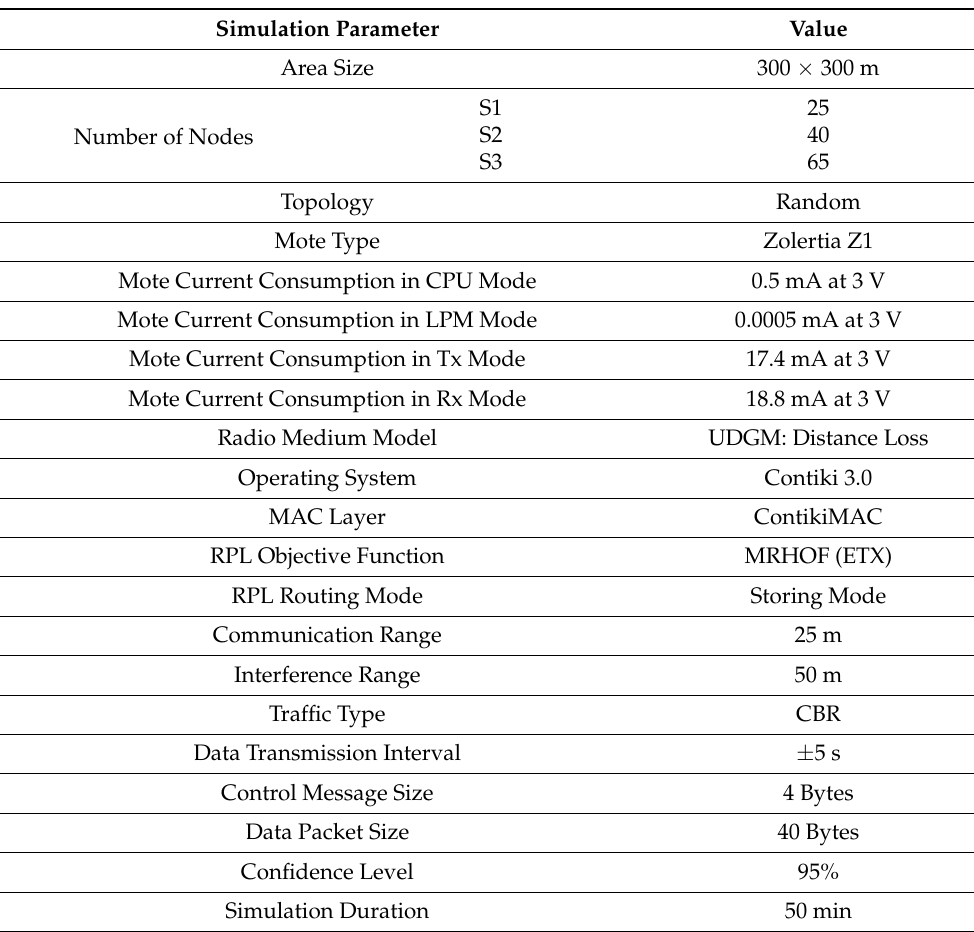
Figure 2. Network Topology of S2. Table 2. Simulation Parameters.